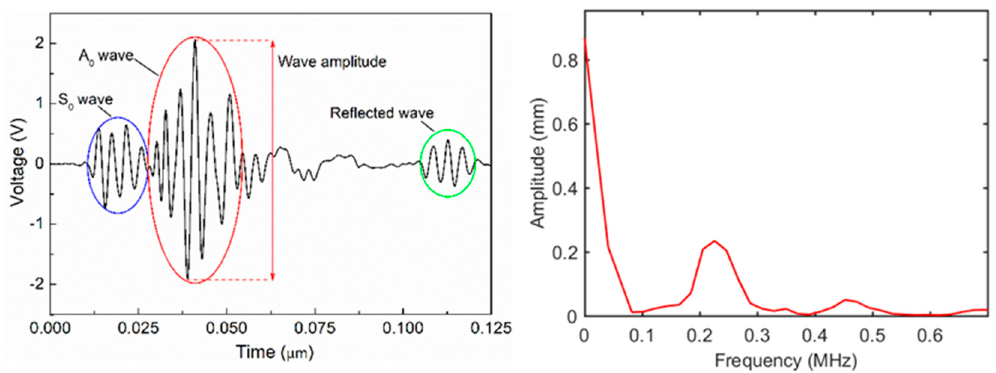
Figure 7. Typical wave signal received by AE sensor.